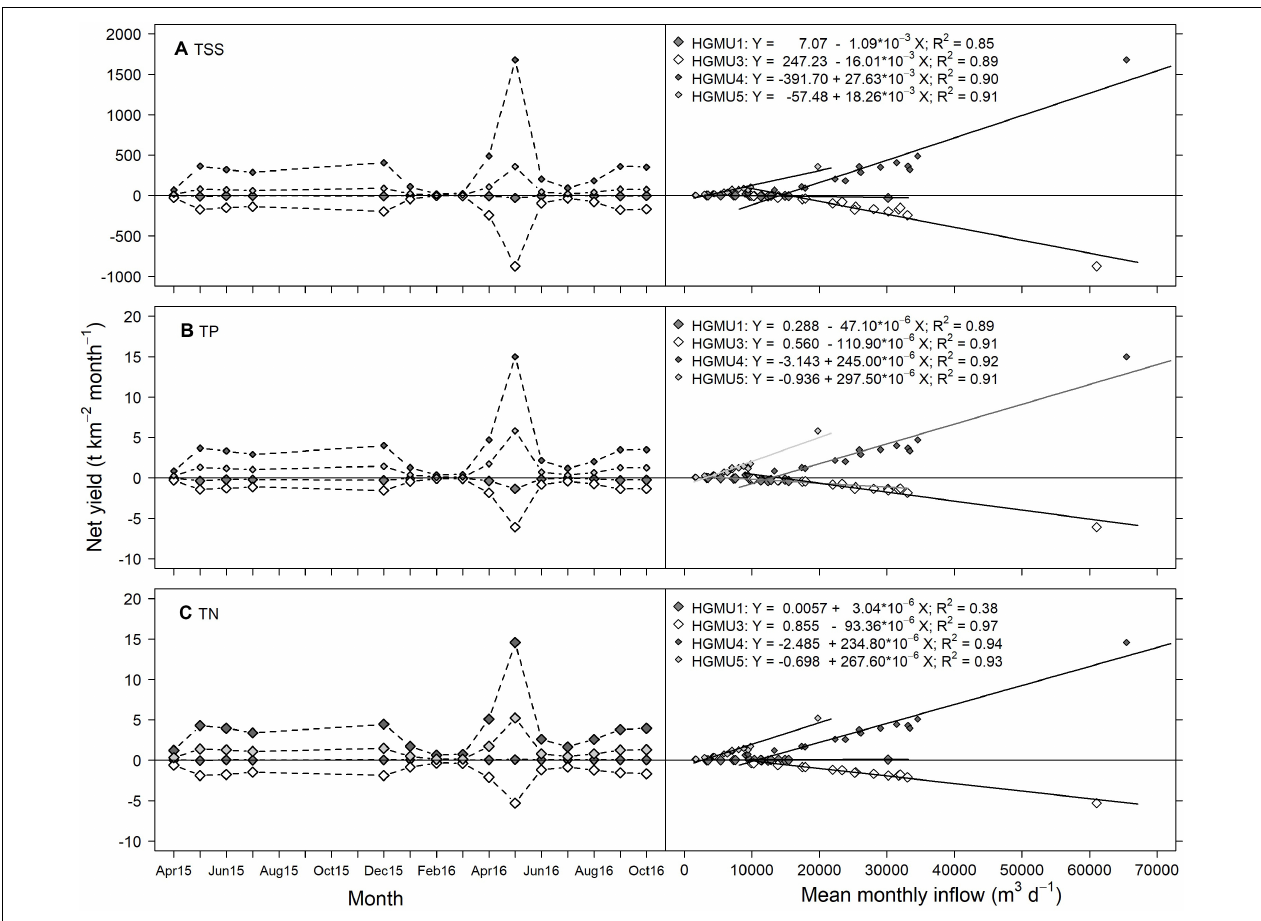
FIGURE 10 | Net yield (tonnes km − 2 month − 1 ) (left panel), and regression of net yield (Y) on mean monthly inflow (X) (right panel). (A) Total suspended solids (TSS); (B) Total phosphorus (TP); (C) Total nitrogen (TN). Data are from the period April 2015–October 2016 in HGMUs 1, 3, 4, and 5 of Namatala Wetland. For further explanation, see